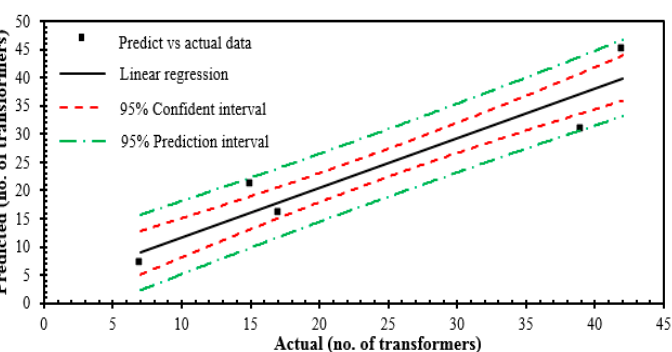
Figure 6. Predicted versus actual numbers of transformer in the year 2014 based on transformer transition states for the year 2012/2013.